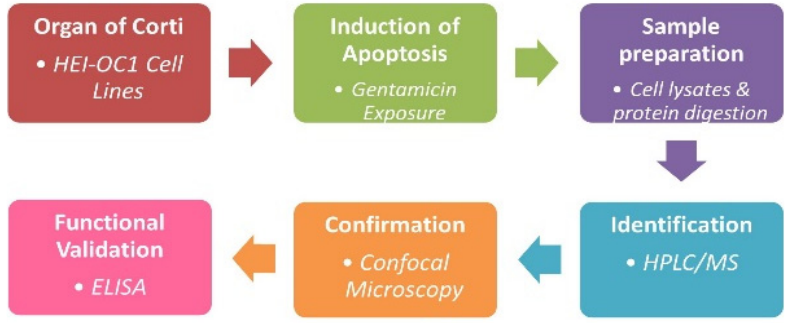
Figure 1. Schematic representation of experimental design for HPLC-MS/MS.